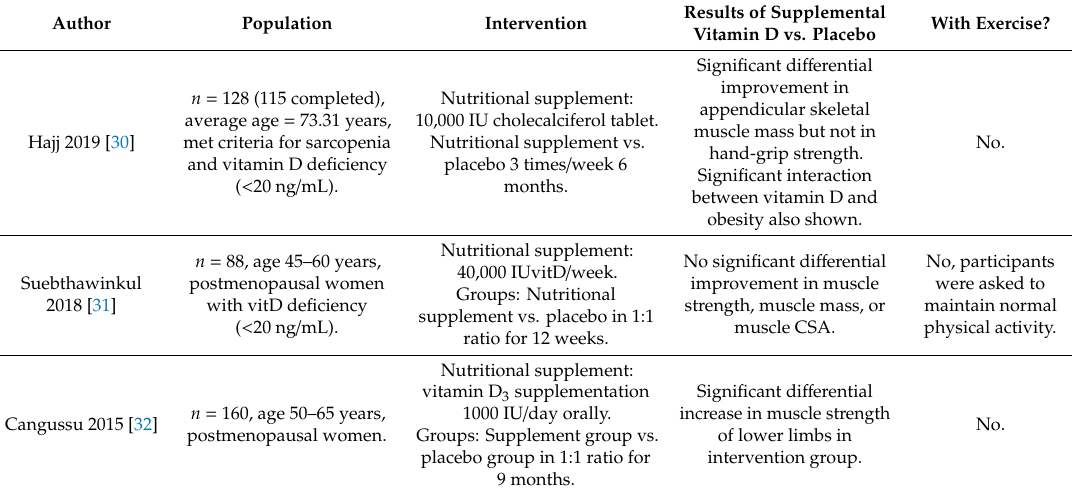
Table 2. Randomized controlled trials of vitamin D supplementation and